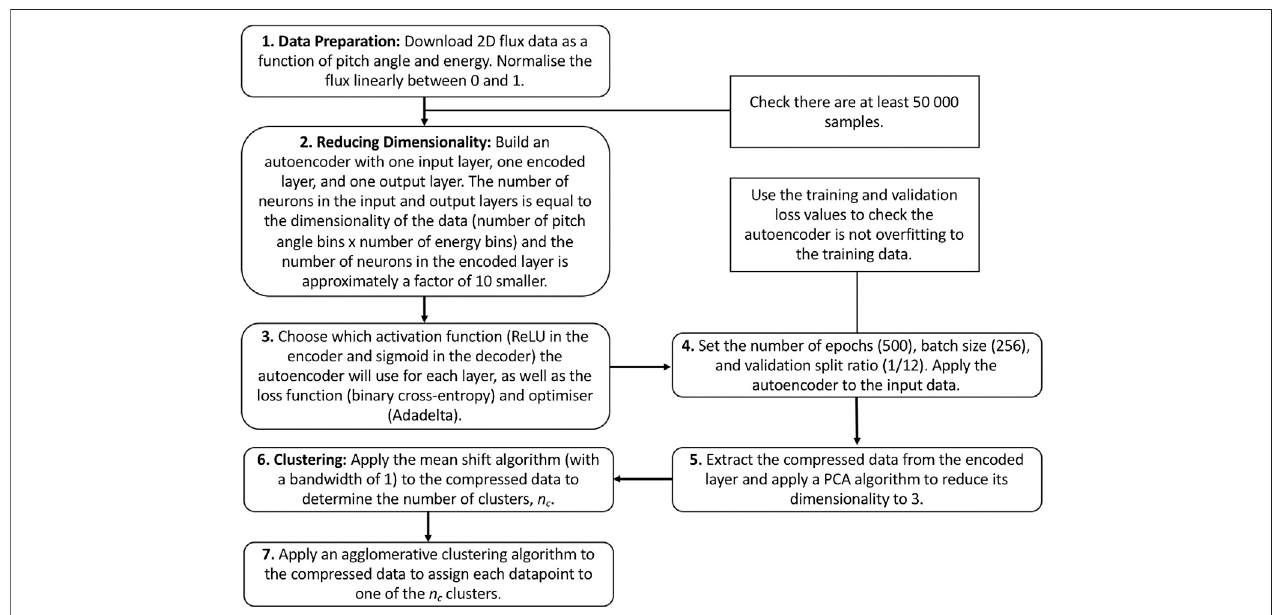
FIGURE3| Flowdiagramillustratingthestepswetaketoreducethedimensionalityofthedatasetandsubsequentlyapplyclusteringalgorithmstocharacterizethe different populations. Our choices for the functions and input parameters necessary to train the autoencoder are shown in brackets in steps 3 and 4.